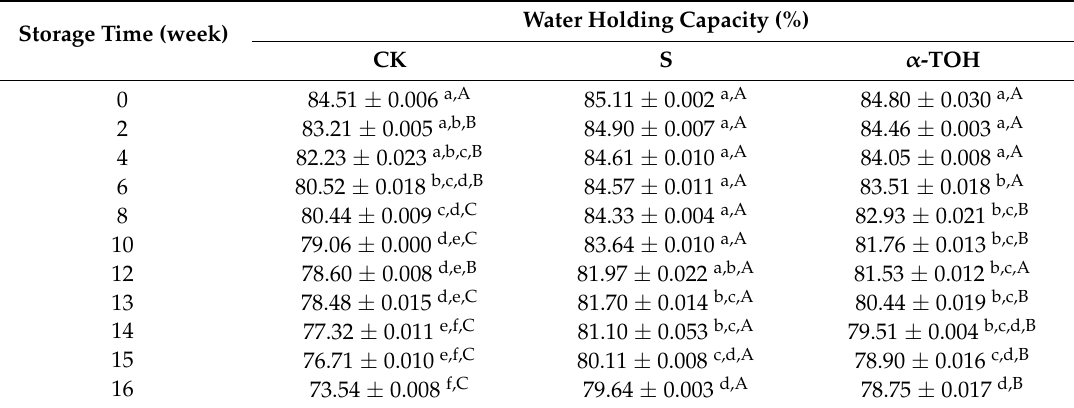
Table 1. Effect of α -TOH on the water-holding capacity of sturgeon surimi during frozen storage at − 18 ◦ C for 16 weeks.